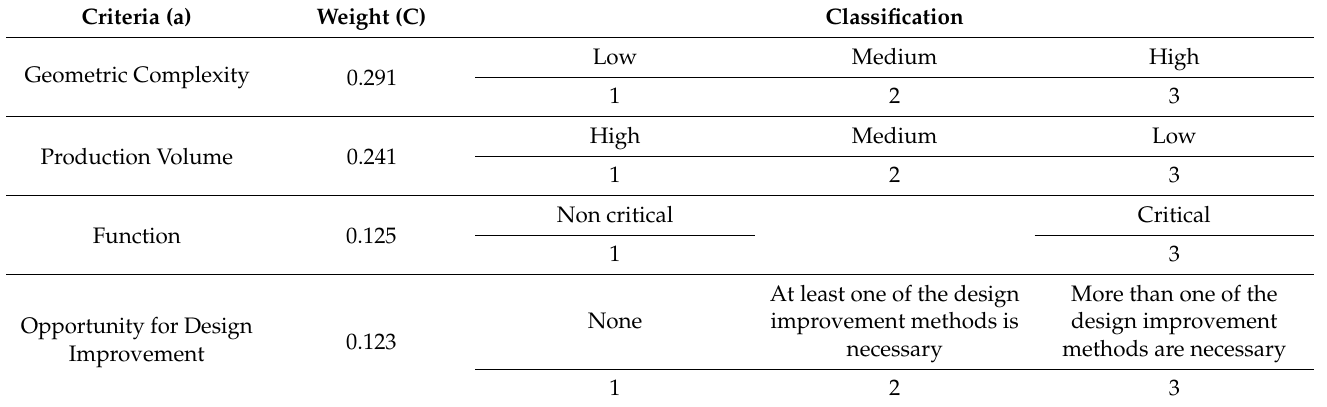
Table 9. Decision matrix for selecting part